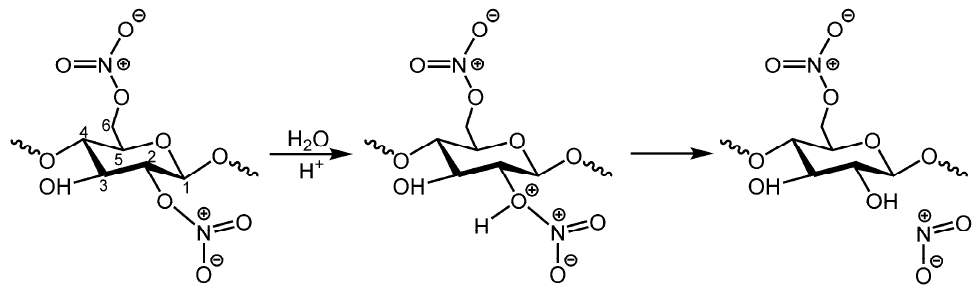
Figure 2. Scheme illustrating the most probable pathway of hydrolysis of the ester links when it compromises the nitro groups